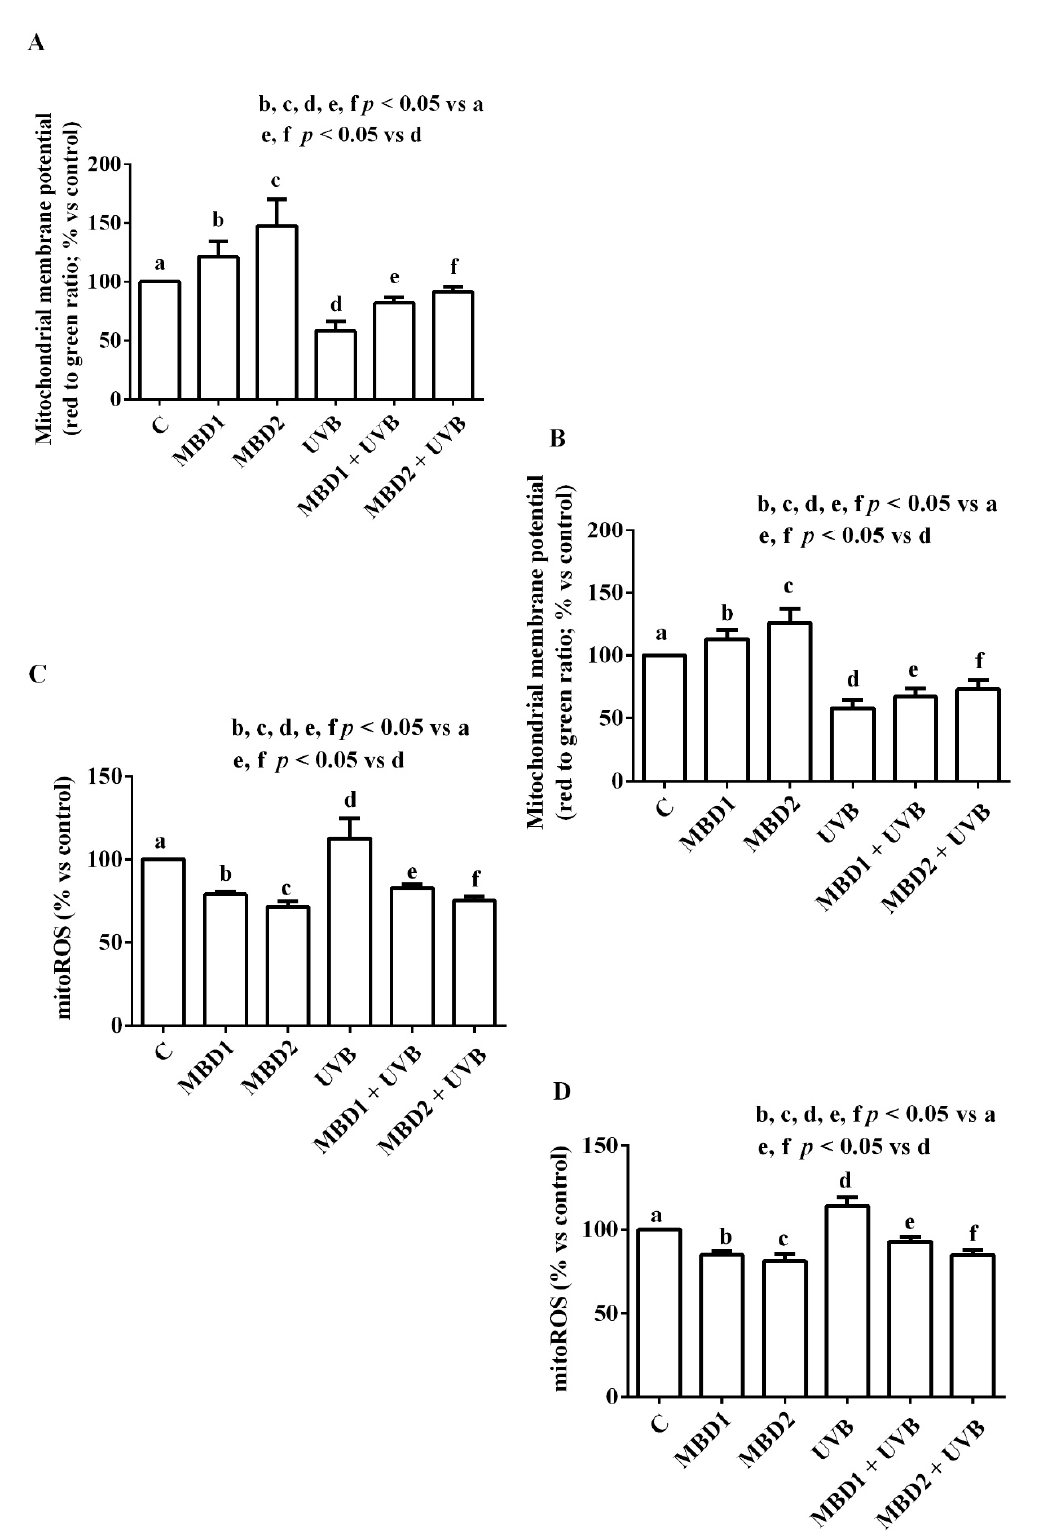
Figure 5. Effects of MBD with ( A , C ) and without PEG ( B , D ) on mitochondrial membrane potential ( A , B ) and mitochondrial reactive oxygen species (mitoROS) release ( C , D ) in RGC-5 cells. MBD1: MBD at 3 × 10 − 5 M. MBD2: MBD at 7.8 × 10 − 4 M. UVB at 0.117 J/cm 2 (for 30 min). The results are means ± SD of repeated experiments. C: control cells (non-treated).